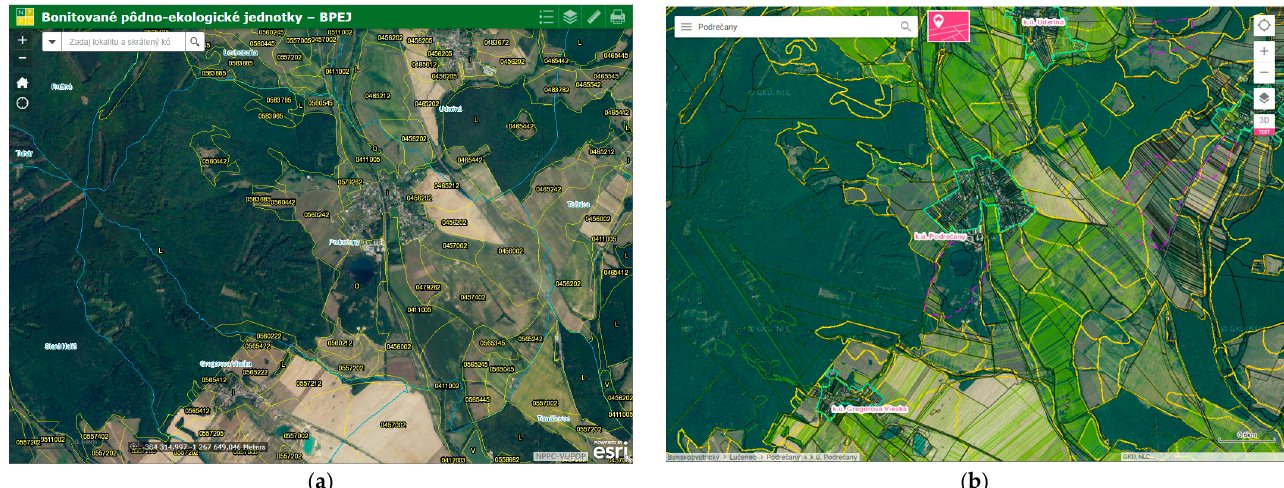
Figure 4. Map portals with EPEU layers: ( a ) Soil portal (Source: https://portal.vupop.sk/portal/apps/webappviewer/index.html?id=1b9830b956ac411e9789aac54effa744, accessed on 21 September 2021); ( b ) Geoportal ZBGIS (Source: https://zbgis.skgeodesy.sk/mkzbgis/sk/kataster?bm=orto&z=14&c=19.616018,48.400452&sc=n#, accessed on 5 September 2021).